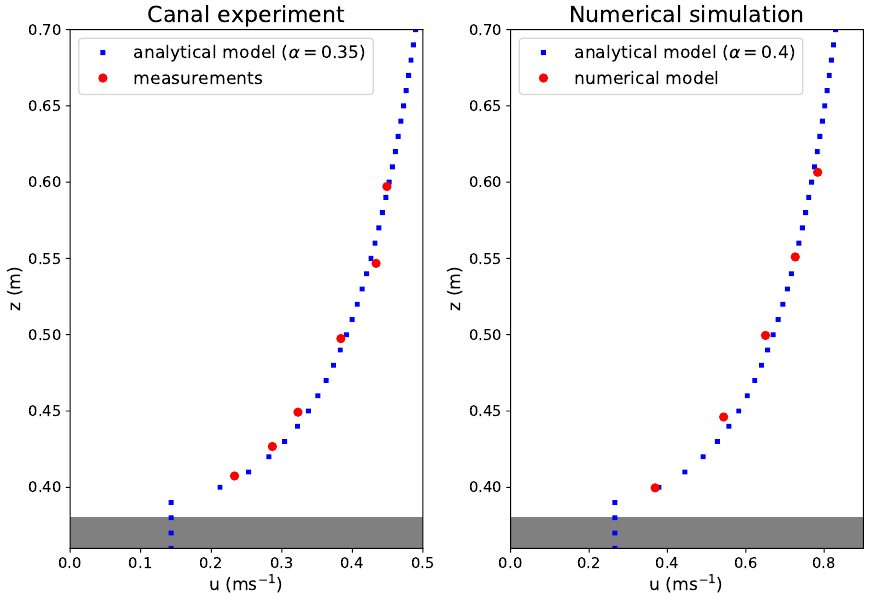
Figure 4. Vertical profiles of horizontal velocity over the oyster table obtained with the analytical model against velocity profiles ( left ) measured by Kervella et al. [13] and ( right ) computed by Gaurier et al.